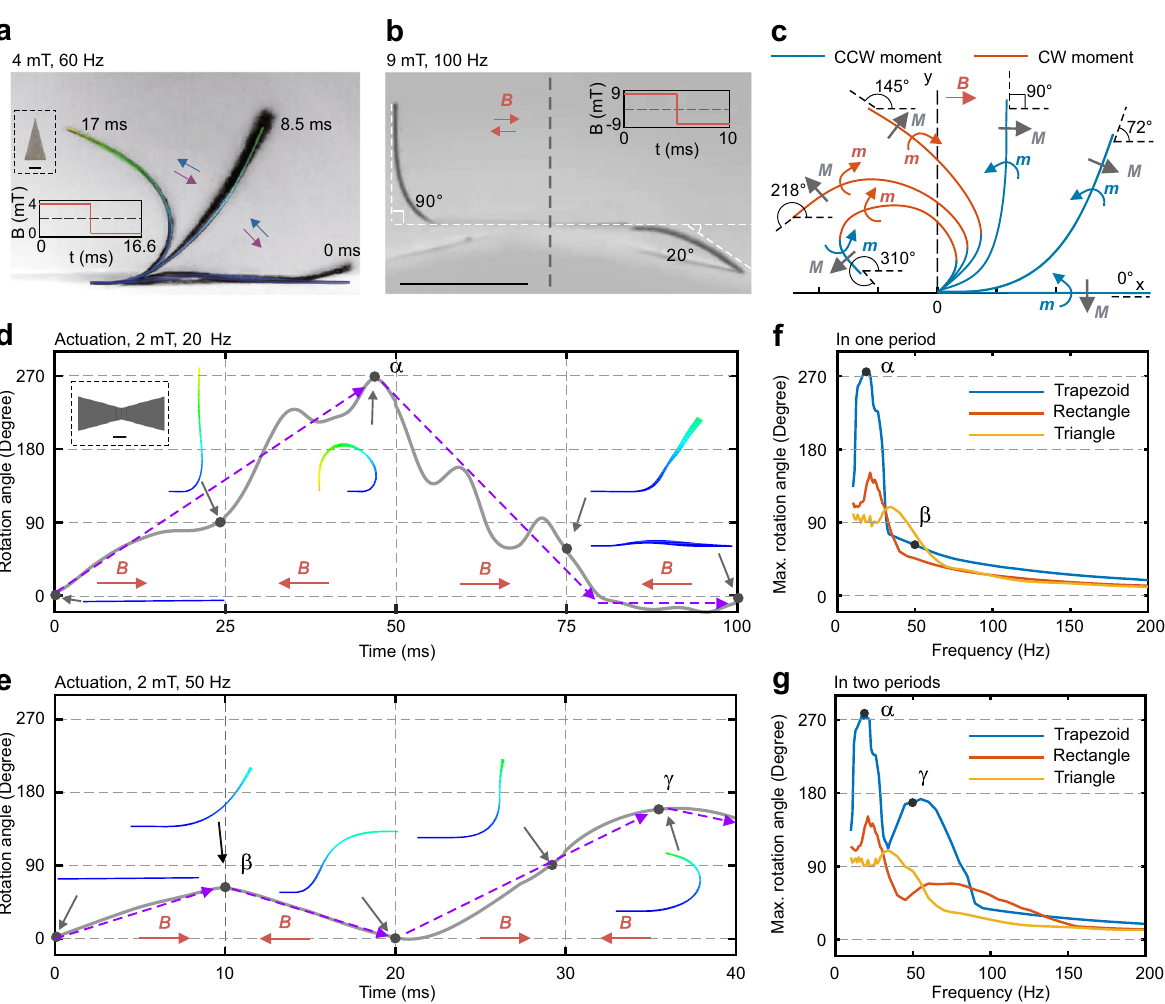
Fig. 2 Dynamics and actuation performance of a magnetic soft robot. a Experimental and simulated snapshots present one actuation period of a one-arm triangle-shaped robot driven by a square wave magnetic fi eld (4 mT, 60 Hz, shown in the inset or the form as Supplementary Fig. 2b) (Supplementary Movie 4). One end of the robot is fi xed on a substrate. b Experimental snapshot revealing 90° deformation of a two-arm rectangle-shaped robot (lateral dimensions: 6 × 0.8 mm 2 , thickness: 45 µ m) at a driving frequency of 100 Hz when the amplitude of the magnetic fi eld is 9 mT (square wave). See also Supplementary Fig. 8 and Supplementary Movie 5. The middle point of the robot is fi xed on a curved substrate. c Direction of magnetization M and magnetic torque m of a one-arm triangle-shaped robot during actuation as shown in ( a ). d , e Time-dependent rotation angle during the actuation of a one- arm trapezoid-shaped robot driven by a square wave magnetic fi eld (2 mT) at 20 and 50 Hz, respectively. Maximum rotation angles are highlighted with Greek letters: α is the maximum rotation angle achieved at 20 Hz, β at 50 Hz for one period, and γ at 50 Hz for two periods. The purple lines indicate the trend of the variation of the angle. f , g Calculated frequency-dependent maximum rotation angles of differently shaped robots for one and two periods driven by a square wave magnetic fi eld (2 mT), respectively. Scale bars, 0.2